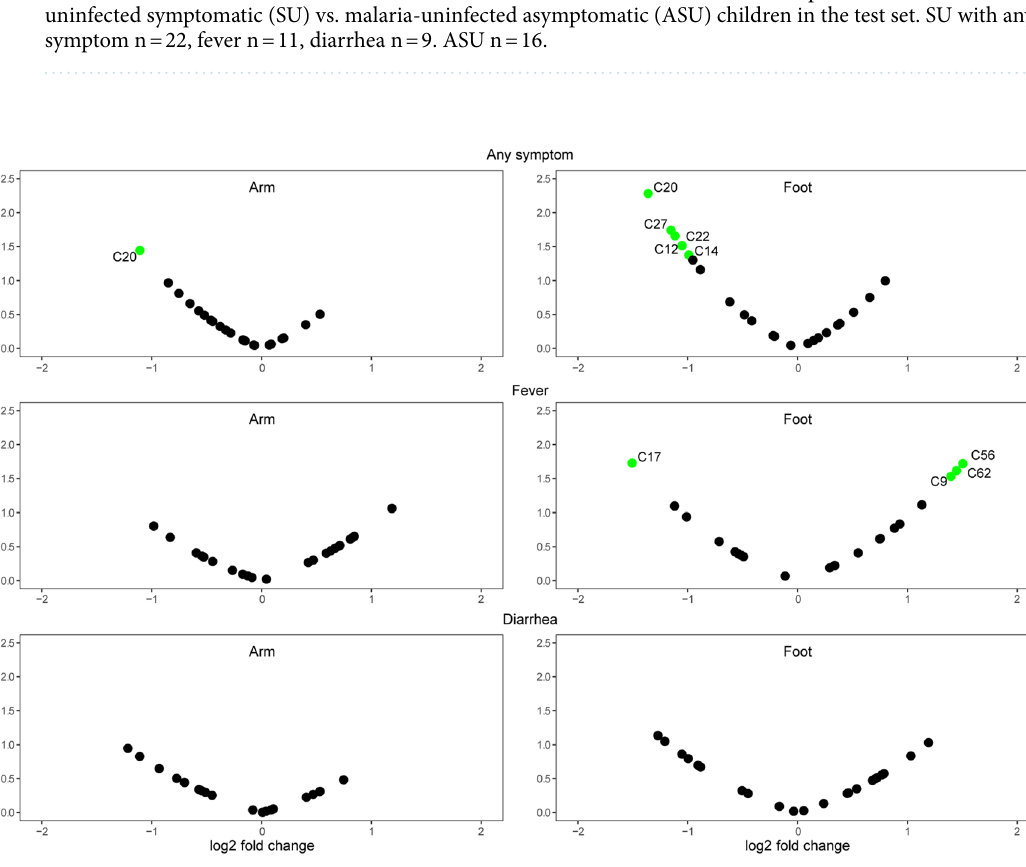
Figure 3. Volcano plots showing changes in individual compounds in malaria-uninfected symptomatic children relative to malaria-uninfected asymptomatic children. Significantly up- or downregulated compounds ( p < 0.05 and absolute fold change > 1.5) are shown in green. Compound IDs are listed in Table